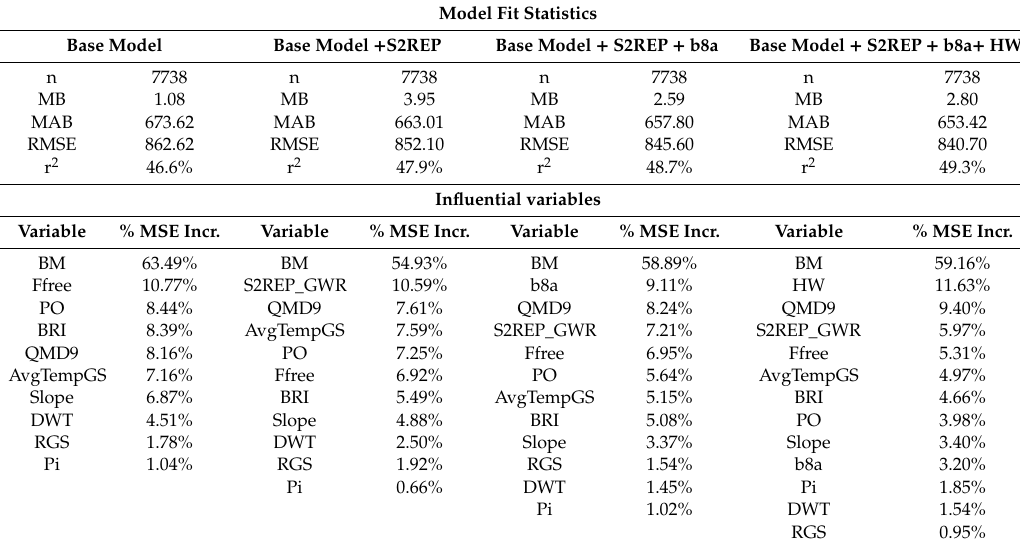
Table 6. Improved biomass growth index (iBGI; kg ha − 1 year − 1 ) model performance using Random Forest (RF) as compared with the base biomass growth index (BGI) model.